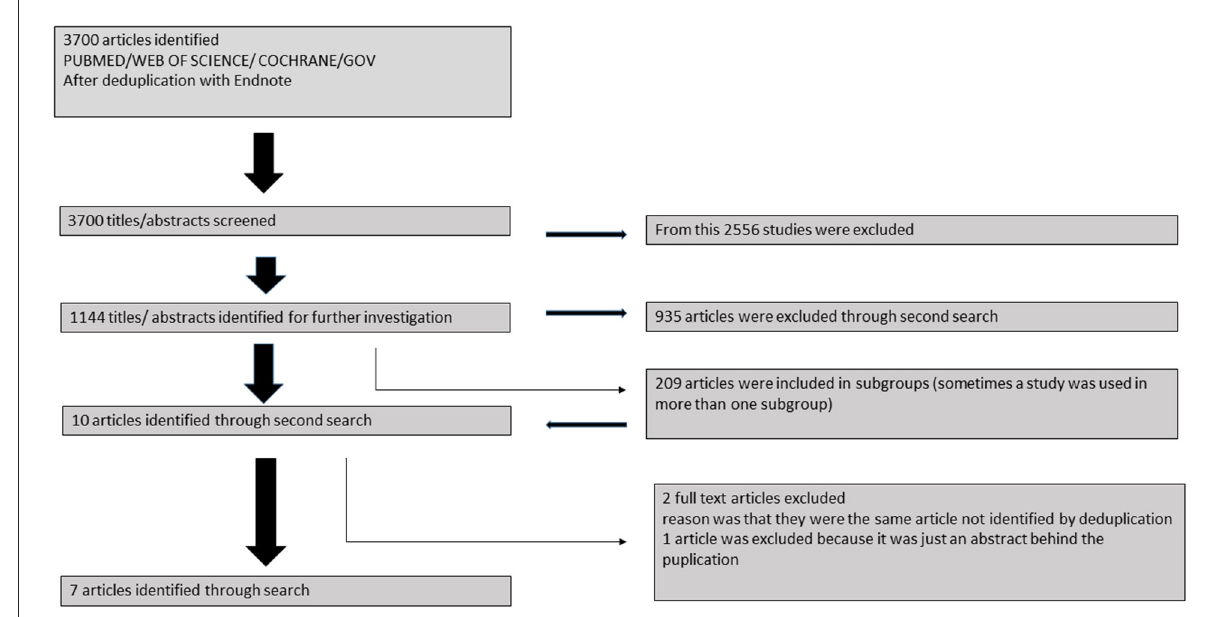
FIGURE1 Flowchart of recruitment criteria of the present study. Finally 44 patients were included from 7 studies.